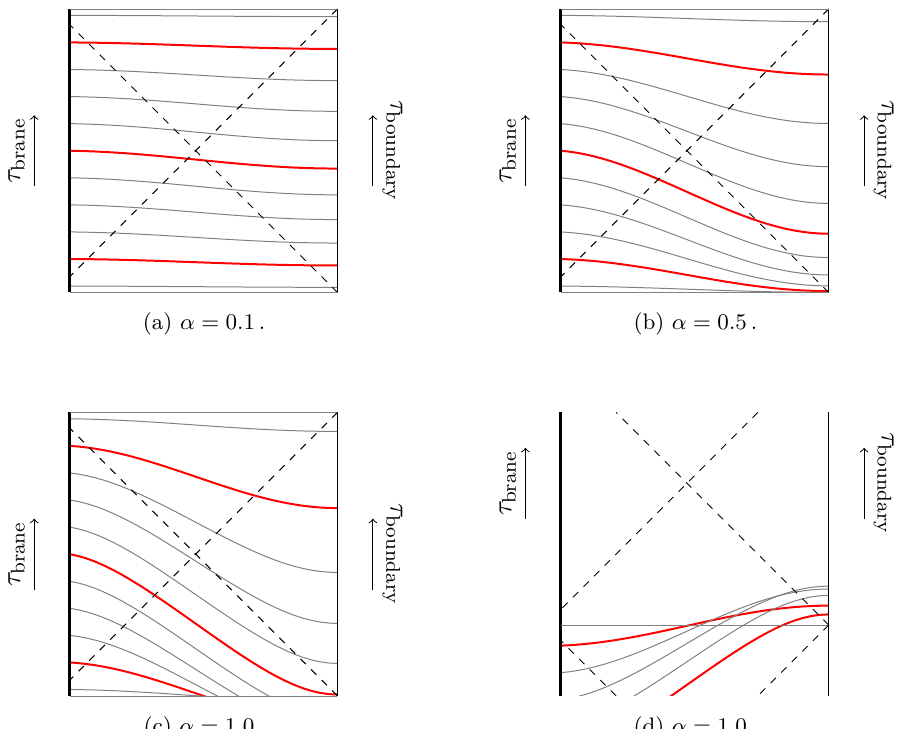
Figure 5 . A family of RT surfaces emanating from the brane at different times. For (a), (b), (c) the red RT surfaces start at τ brane = 0 , 1 . 2 and y brane = 1 . 4 . (a) For α = 0 . 1 , the RT surfaces ± − get deformed compared to case of vanishing DGP coupling in figure 4, such that their ends are now at τ boundary < τ brane . (b) This trend becomes more prominent at α = 0 . 5 . (c) At α = 1 . 0 we see that some extremal surfaces leave the patch of interest and end on the asymptotic boundary of a “previous universe.” (d) For large enough α there are other extremal surfaces which end on the brane in the analytic continuation of the spacetime. The red surfaces start at τ brane = 1 . 8 , 3 . 0 − −